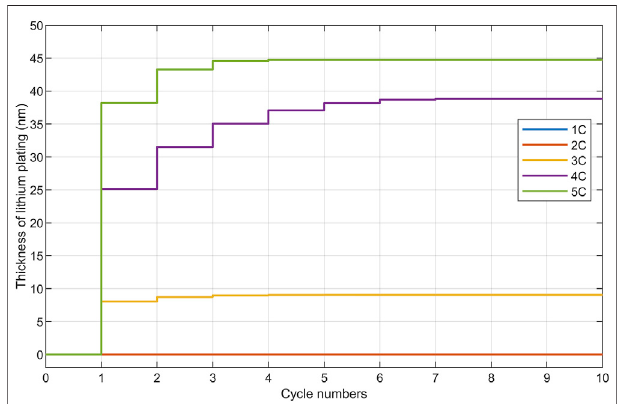
FIGURE 5 | In fl uence of charge rate on lithium plating thickness at room temperature.